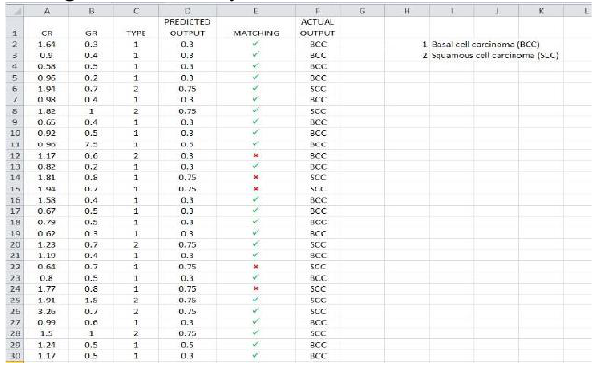
Fig. 11. Comparison of actual Vs. predicted